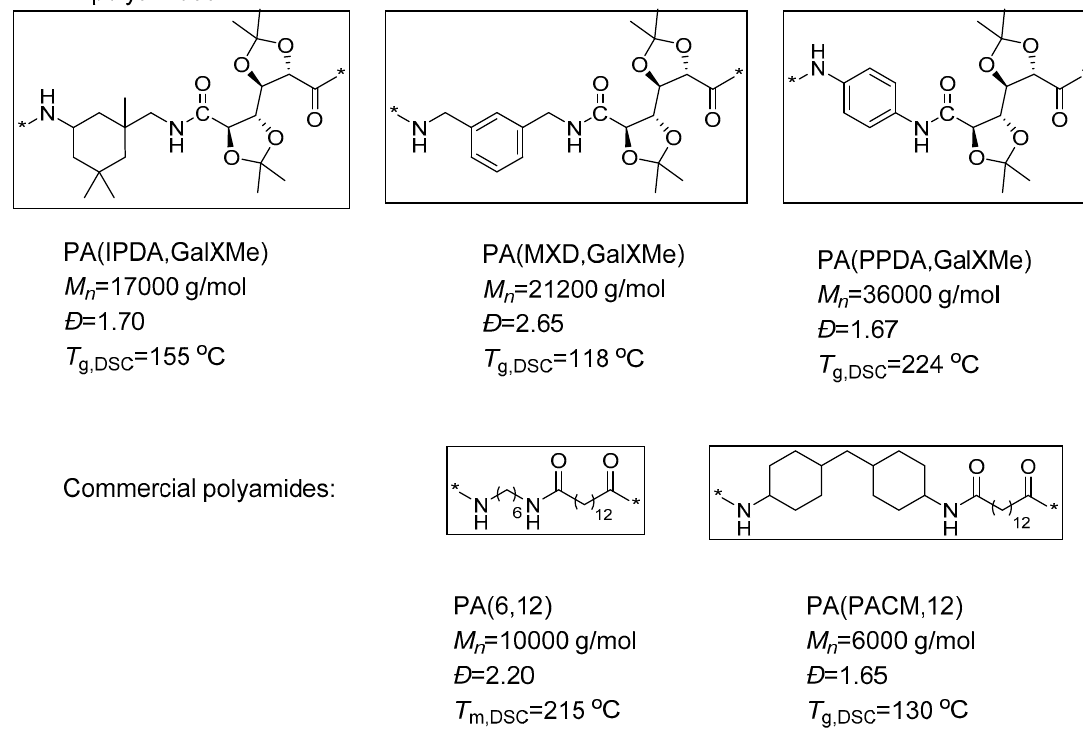
Figure 2. Structures and molecular weight data of polyamides composed of acetals of galactarate (GalX) and diamines (PA(IPDA,GalXMe), (PA(MXD,GalXMe), and PA(PPDA,GalXMe)) as well as commercial polyamides ((PA(6,12) and PA(PACM,12)) that were chosen for the blending experiments.